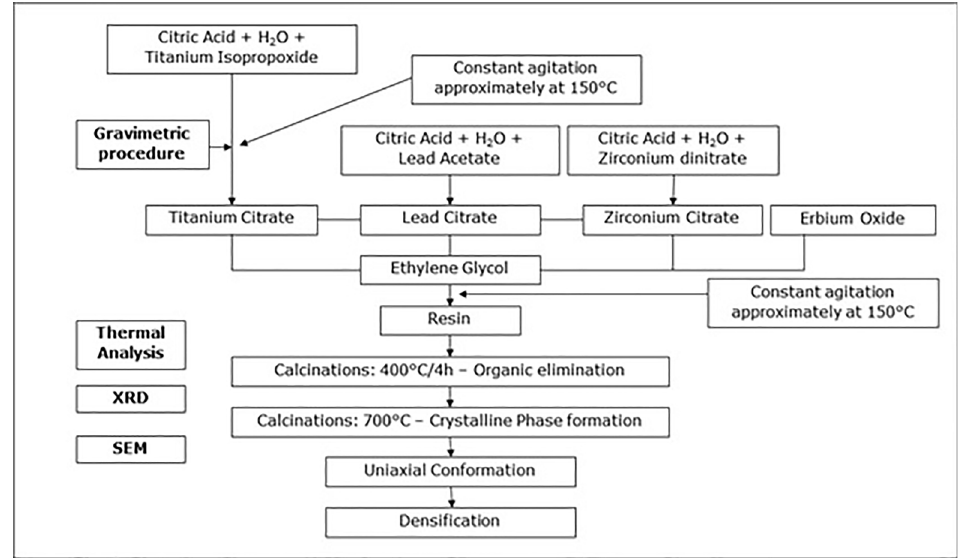
Figure 2. Flowchart for obtaining PZT doped with erbium via the Polymeric Precursor